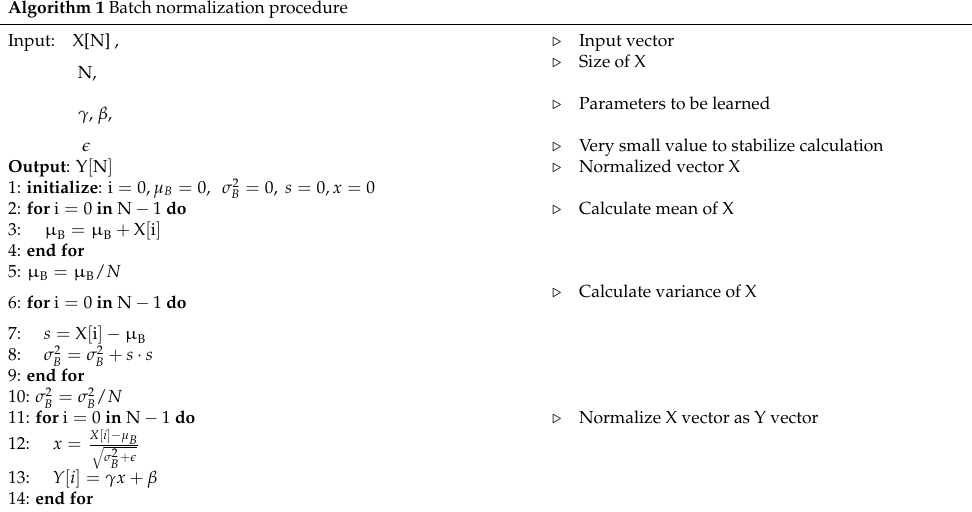
Algorithm 1 Batch normalization